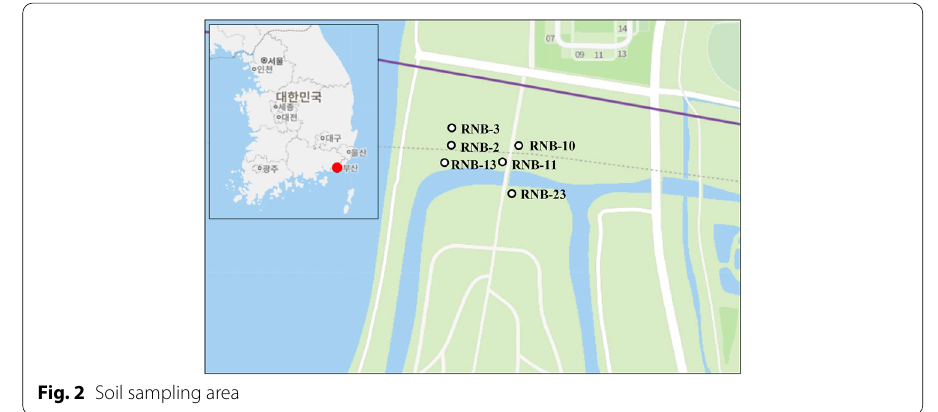
Fig. 2 Soil sampling area